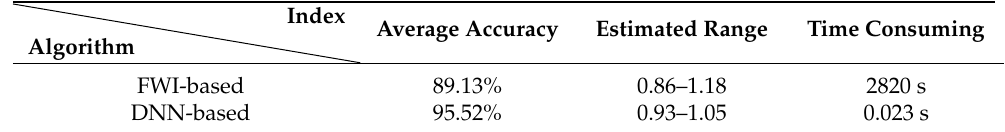
Table 2. Comparison with